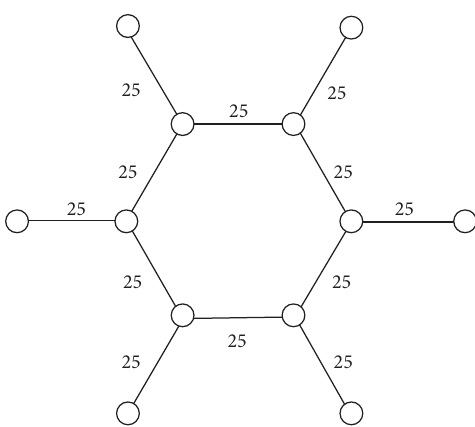
Figure 12: Layer 4 with edge